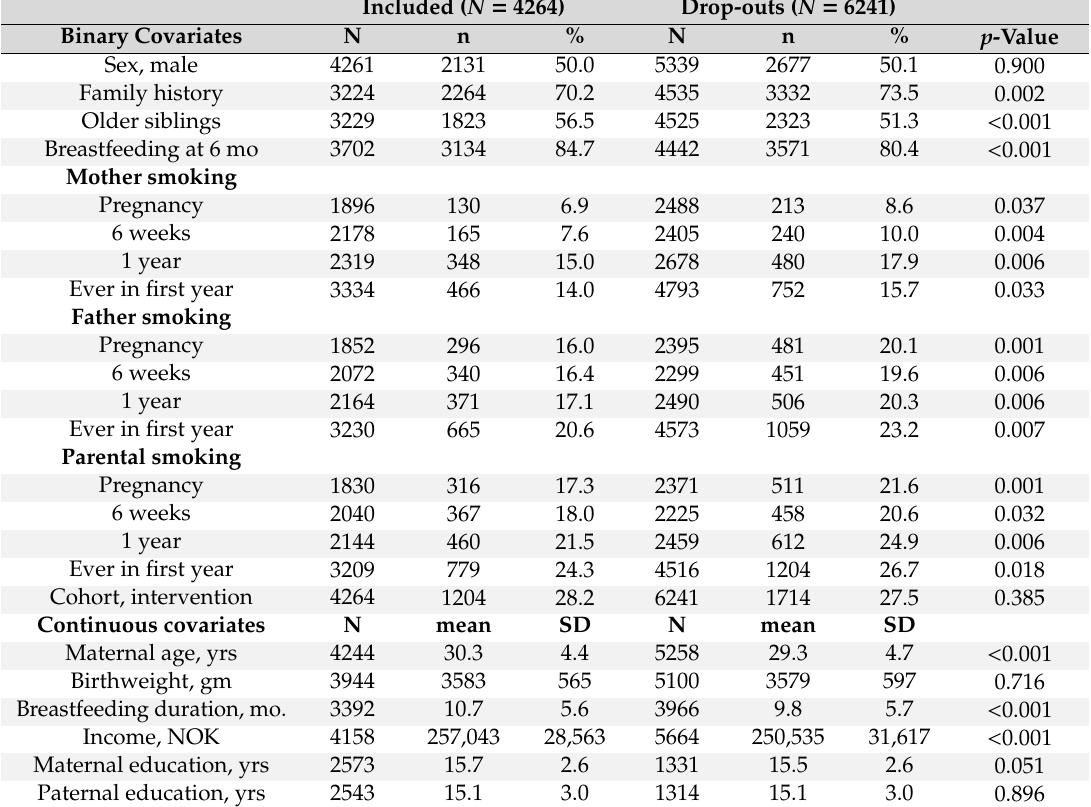
Table 1. Baseline characteristics of included mother-infant pairs and